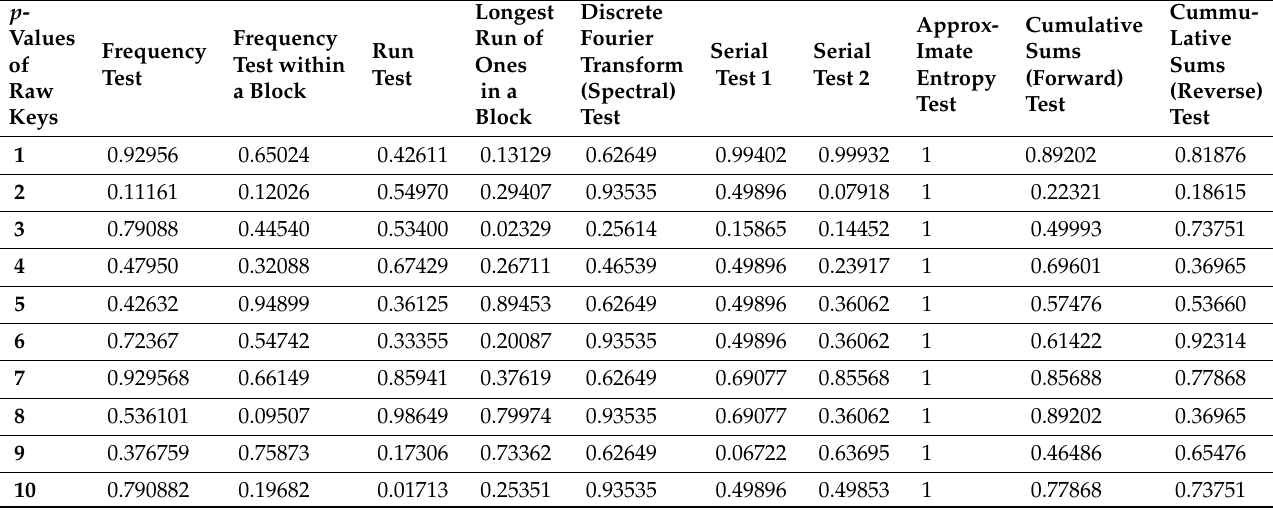
Table 5. p -values of appropriate NIST statistical tests on Randomness applied to Raw Key (512 bit) of B92. Conclusion: Random.